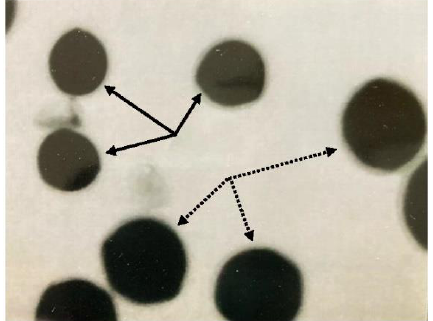
Figure 1. Smaller n = 2x pollen grains (solid arrows) typical of tetraploid pollen, and larger n = 4x grains typical of octoploid pollen (dotted arrows). Photo X450; 1 cm = 40 microns.